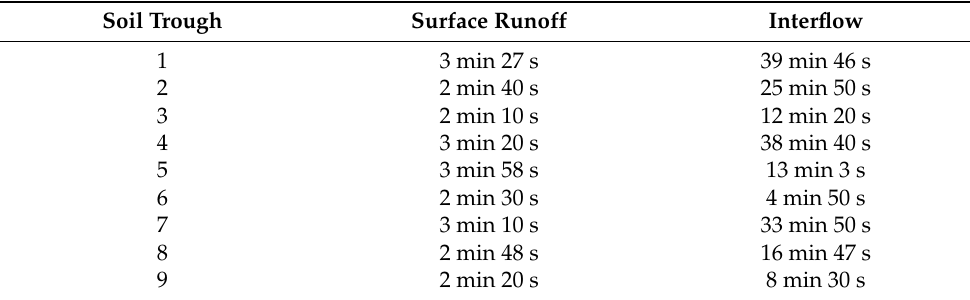
Table 3. Initial loss durations of surface runoff and interflow in soil troughs. Soil Trough